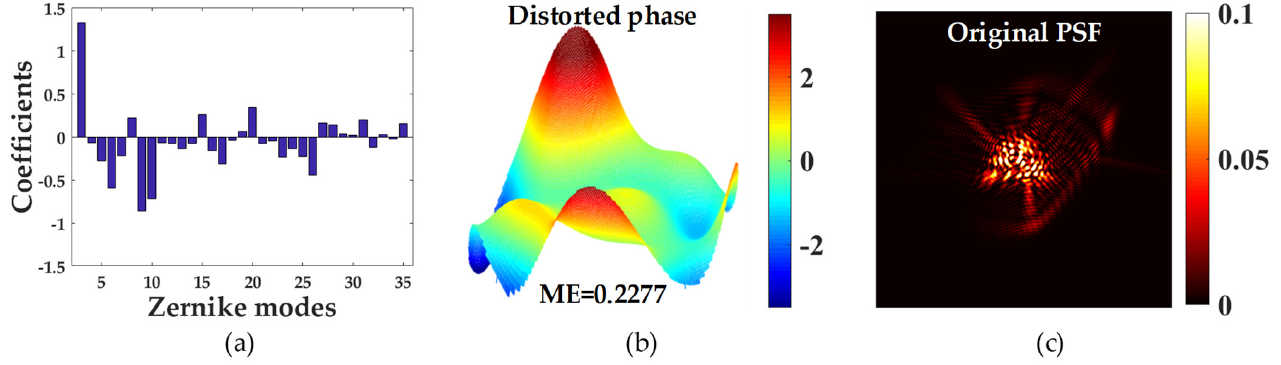
Figure 3. Random set of simulated data: ( a ) initial Zernike coefficients of the wavefront aberration; ( b ) corresponding distorted phase of the original wavefront; ( c ) corresponding original PSF.